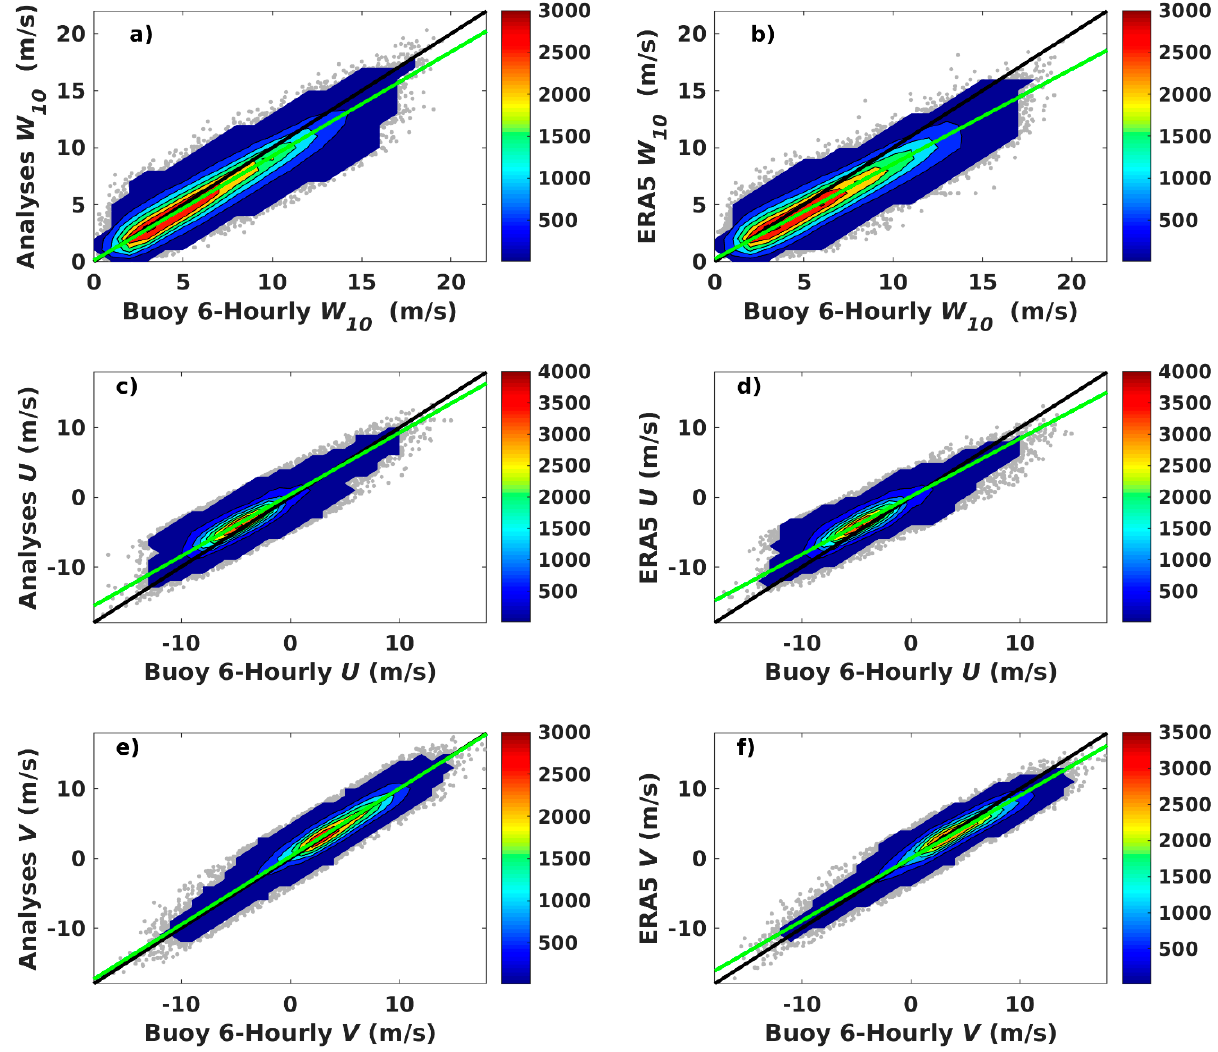
Figure 4. Offshore comparisons of 6-hourly averaged buoy and on one hand IFREMER satellite analyses (left column), and on other hand ERA5 re-analyses (right column). Panels ( a , b ) illustrate wind speed comparisons, ( c , d ) illustrate zonal wind component comparisons, and ( e , f ) illustrate meridional wind component comparisons. Colors indicate sampling length values. Black and green lines indicate the perfect and symmetrical regression lines, respectively.